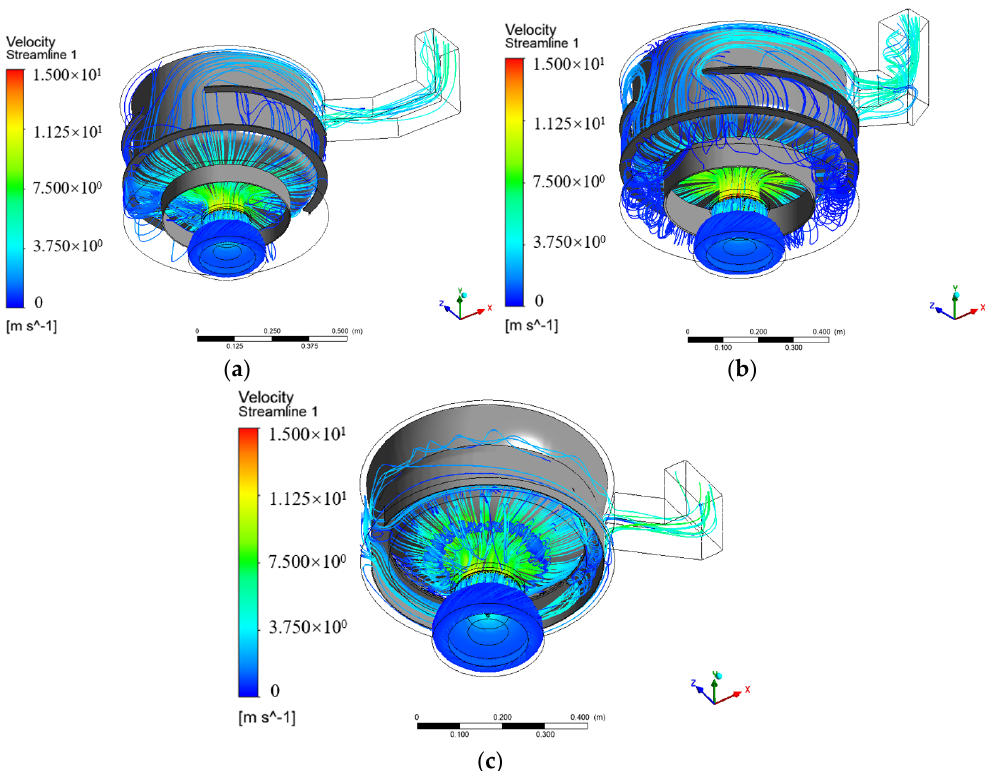
Figure 10. Total heat flux contour of the three stoves at different power rates. The heat flux uniformity of stove A is better than that of stove B because the high- temperature flue gas on both sides of the central flame forms a recirculation zone in the middle of the fireboard, which strengthens the heat transfer in the central area of the ves- sel bottom and also causes a greater difference in the heat flux intensity of the whole ves- sel, resulting in a decrease in the heat flux uniformity index; the streamlines at 40 kW shown in Figure 11 also confirm this finding.